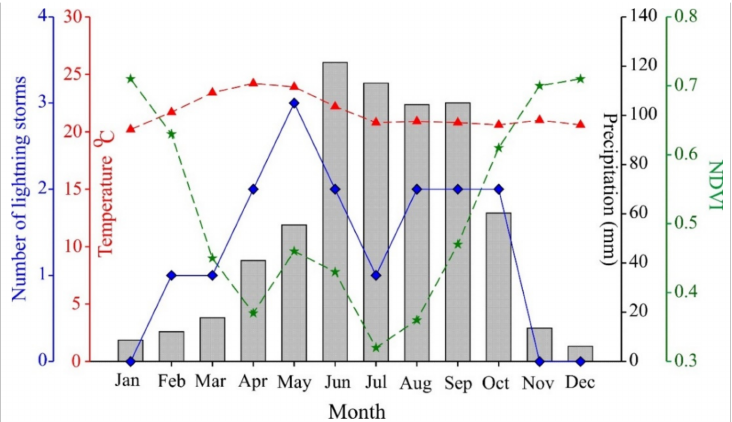
Figure 4. Monthly precipitation (bars) and temperature (red) recorded instrumentally within a weather station near the study area. The frequency of lightning storms is indicated in blue. Precipitation, temperature and lighting storm data are spatially explicit interpolated data based on nearby monitoring stations [37]. Green shows NDVI values, indicative of vegetation photosynthetic rates or vegetation stress levels (1981–2006)